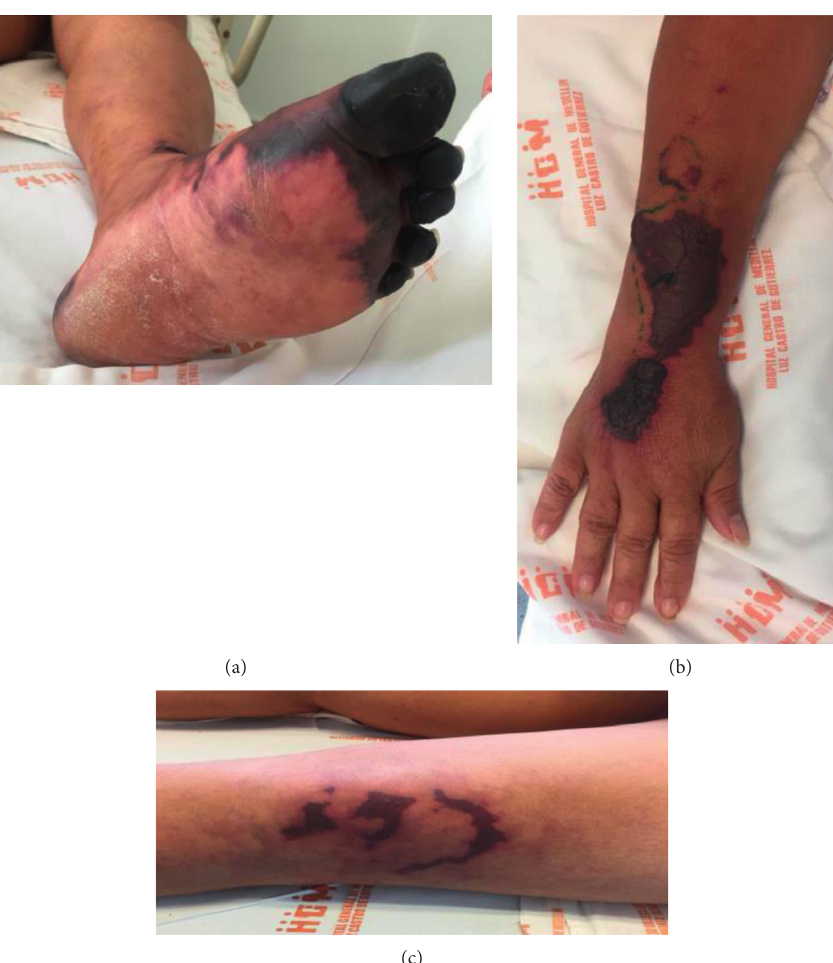
Figure 2: Progression of necrotic lesions on the left foot: new lesions involving the right arm skin and retiform